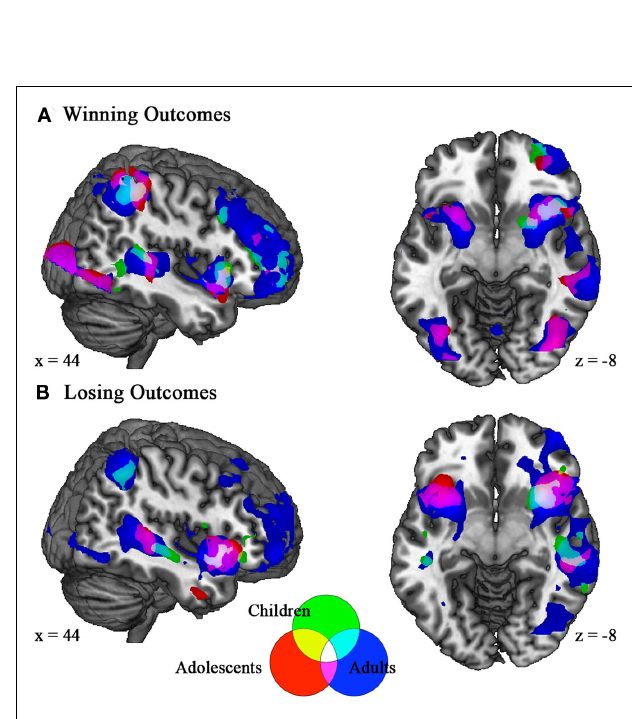
FIGUREA2 |Winning and losing outcomes elicit similar patterns of activation in children, adolescents, and adults. (A) Activations to winning outcomes in all age groups were found in superior temporal gyrus, insula, striatum, inferior frontal gyrus, and inferior parietal regions. Adults and adolescents showed additional activation in dlPFC, lateral OFC, and ACC. (B) Relative losses elicited activation for all age groups in superior temporal gyrus and insula, while adults and adolescents also showed activation in anterior cingulate. Coordinates in MNI space; z >